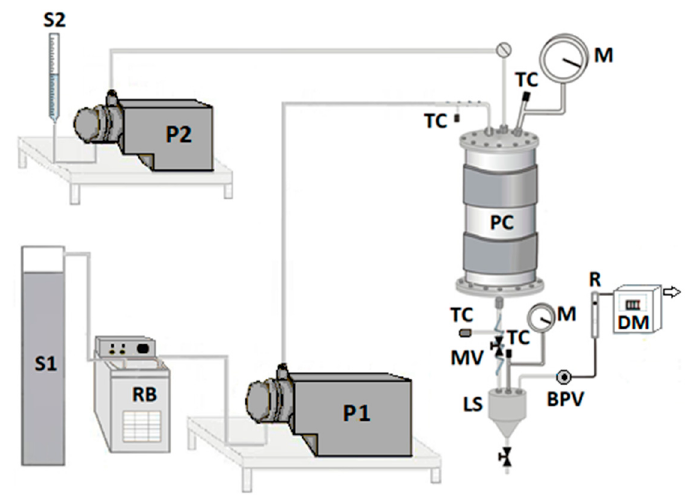
Figure 1. A schematic representation of the SAS laboratory plant.